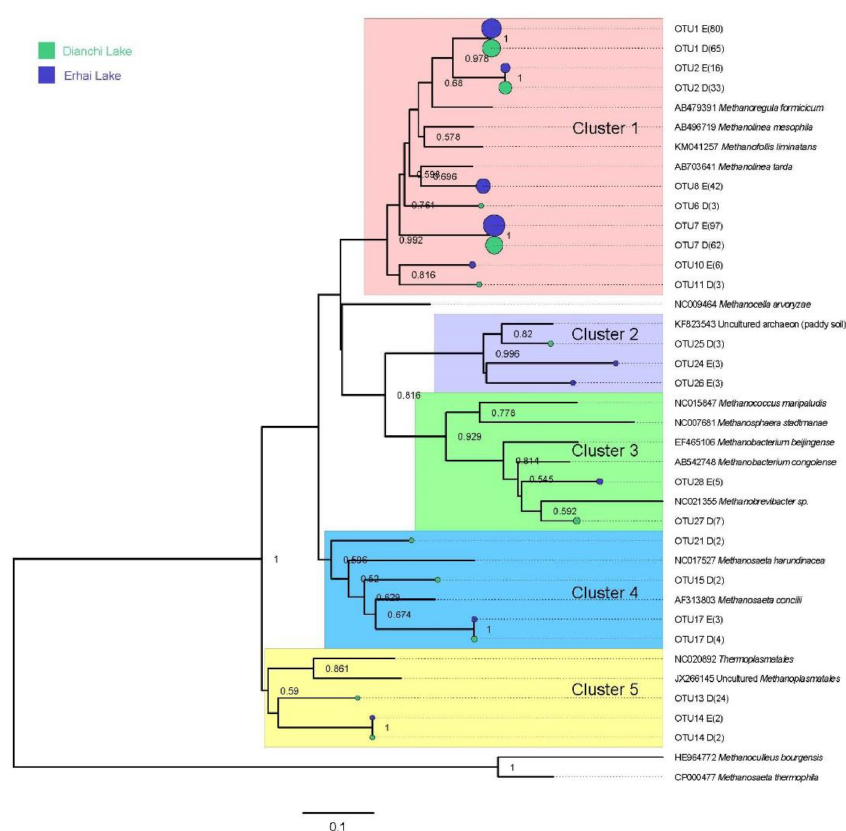
Figure 4. Phylogenetic tree of representative archaeal mcrA sequences and reference sequences from GenBank. The sequences beginning with “D1”–“D6” and “E1”–“E6” were referred to the sequences retrieved from samples D1–D6 and E1–E6, respectively. The number in parentheses, as well as the size of circle, represents the numbers of the total sequences in the libraries of a certain lake. Numbers at the nodes indicate the levels of bootstrap support based on neighbor-joining analysis of 1000 resampled datasets. The values less than 0.5 are not listed. The bar represents 5% sequence